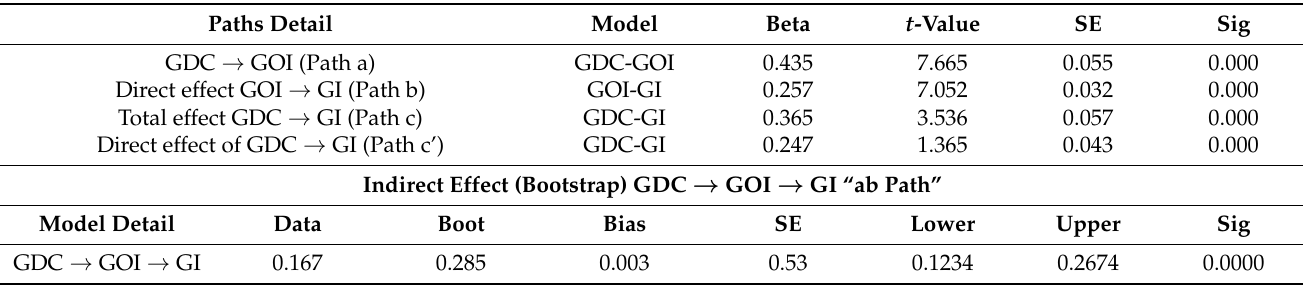
Table 6. Results of Mediation Analysis GDC → GOI →